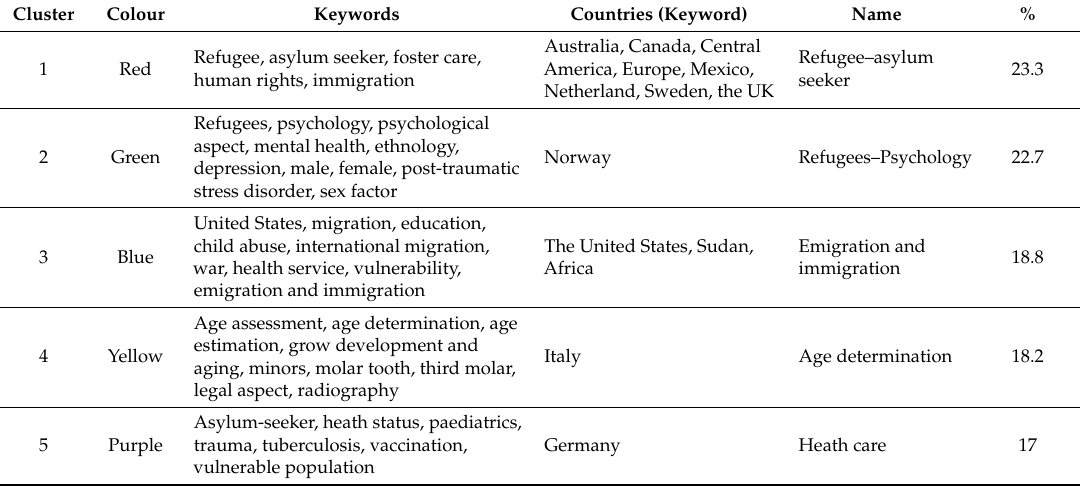
Figure 9. Analysis of keywords used in unaccompanied minors’ works: Relationships among them and clusters. Table 5. Clusters detected in the field of unaccompanied